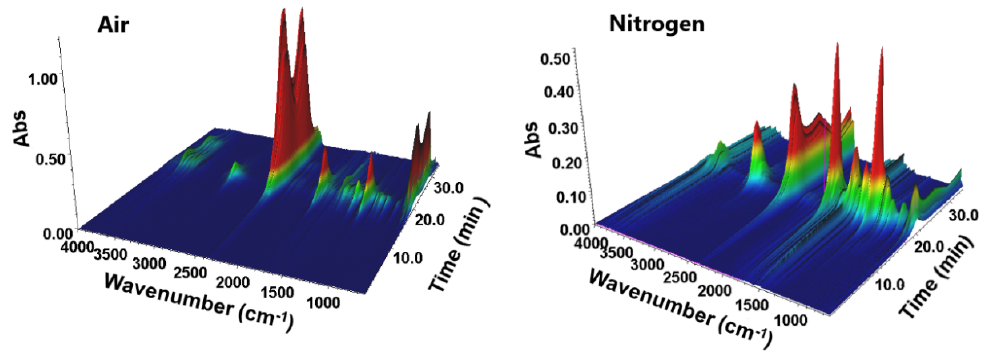
Figure 5. 3D projection of the FTIR spectra of volatile products of BPA.DA-MMA@2%Eu 2 L 3 material decomposition in air and nitrogen atmosphere.